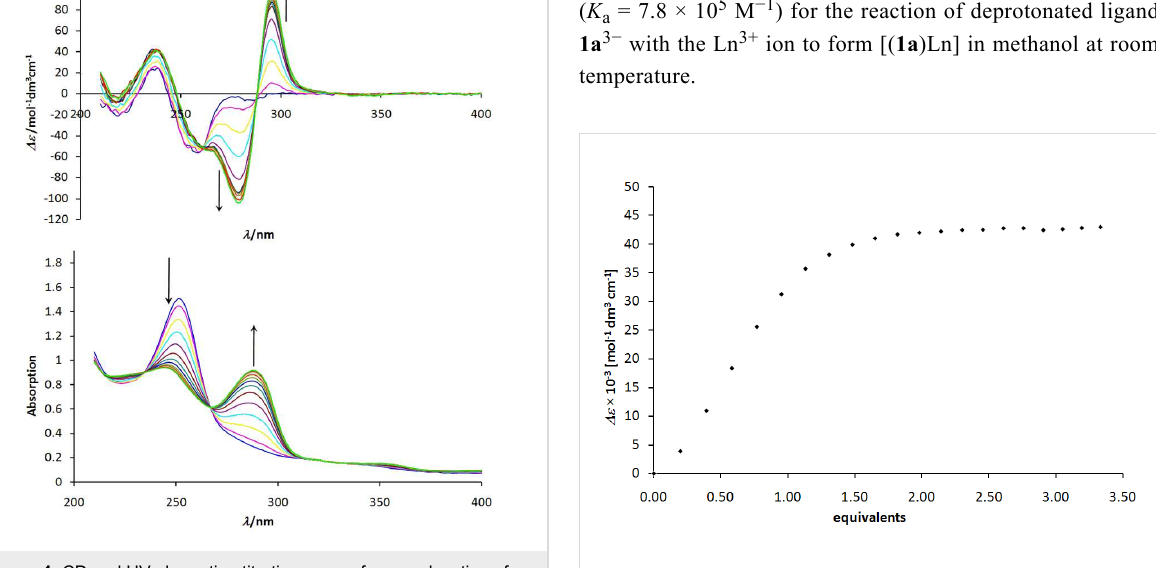
Figure 5: Titration curve observed for ligand 1a -H 3 upon addition of lanthanum(III) nitrate hexahydrate.